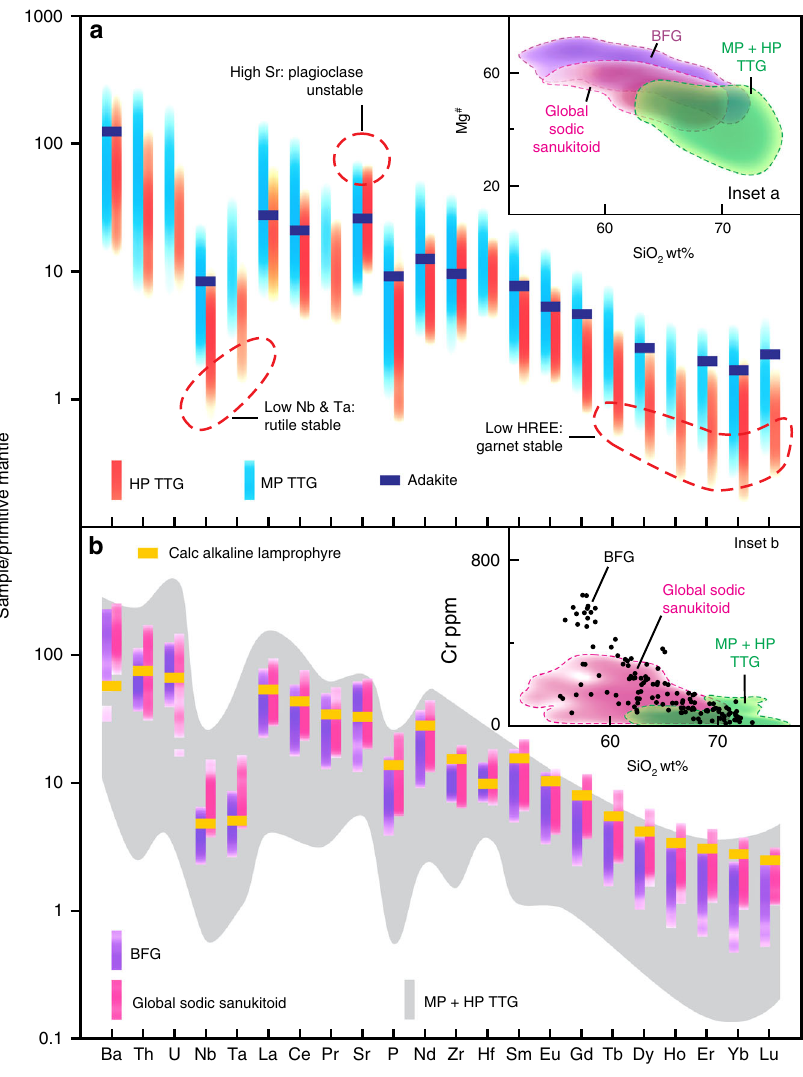
Fig. 1 Trace element patterns of the Black Flag Group (BFG) compared to those of other Archean sodic magmas. Mantle-normalized 57 trace element diagrams comparing; a high pressure (HP) and medium pressure (MP) rocks of the tonalite – trondhjemite – granodiorite (TTG) 9 composition; b rocks of the Black Flag Group and global sodic sanukitoids 58 . The data are shown as kernel density strips after removing 10% outliers (see Methods). Also shown is the average composition of high-Si adakite 26 and of calc-alkaline lamprophyre dykes in the stratigraphy underlying the BFG. Insets a and b: variation in Mg # and Cr (inset a and b, respectively) with SiO 2 (calculated volatile free) for TTG (combined MP and HP), global sodic sanukitoids and rocks of the BFG. Dashed lines outline kernel density plots comprising 90% of the data. Sanukitoid series ideally should be dominated by samples having Mg # >60 and Cr >200 ppm at 60 wt% SiO 2 (ref. 25 ). Whilst some of the global sodic sanukitoids satisfy this criterion, most of BFG rocks have even greater Mg # and